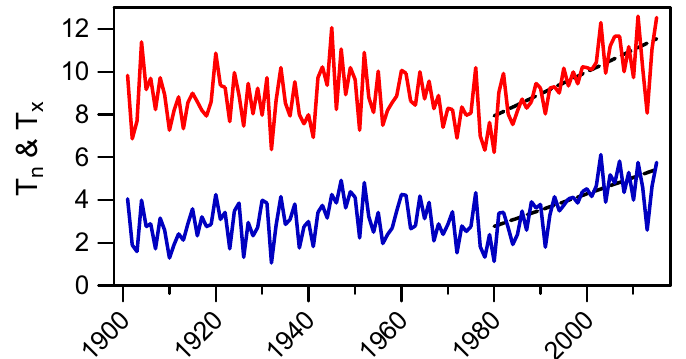
Figure 2. Time courses of mean maximal (red line) and minimal (blue line) April to June temperatures at Mont Aigoual station since 1901 (°C). The warming trend analysis has been done from 1980 (dashed black lines).